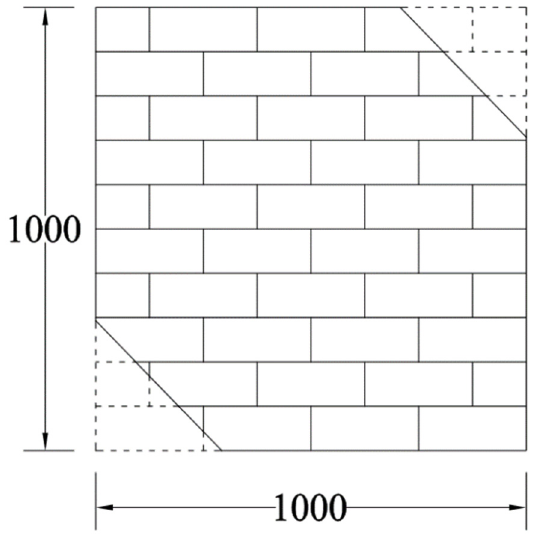
Figure 4. Dimensional details of wall specimens (units: mm).